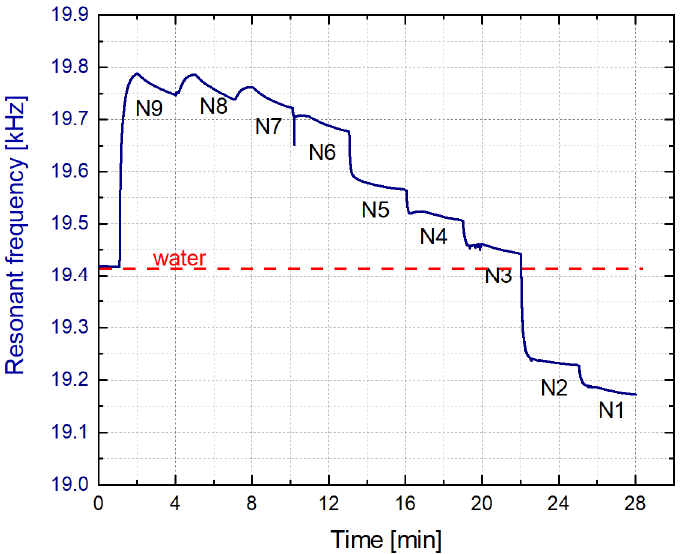
Figure 18. In-line monitoring of the model solutions.